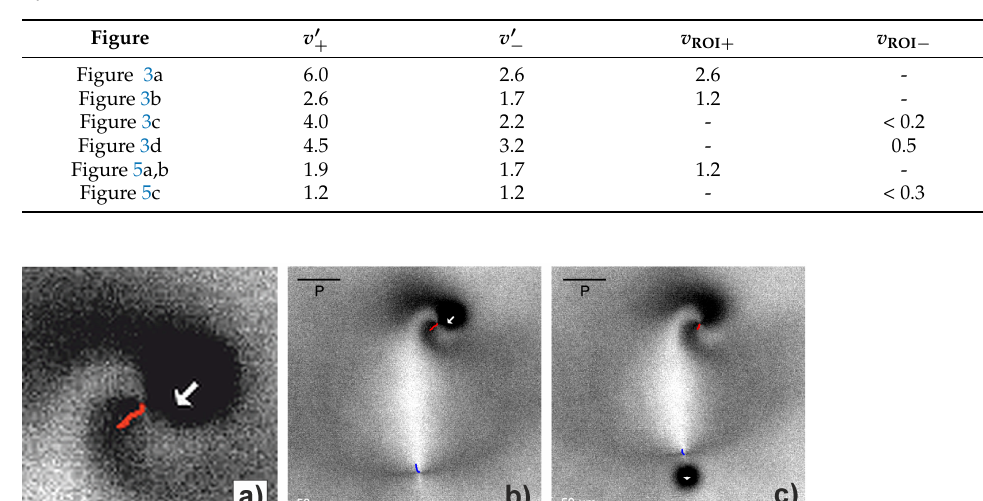
Table 1. Measured flow fields in the images shown in this paper. All velocities are given in µ m/s. The indices ROI+ and ROI − refer to spots near the disclinations with the respective sign. For Figure 3b, the average of the velocities of both bleached spots is given. The accuracy of the veloc- ity data is of the order of 1 µ m/s.